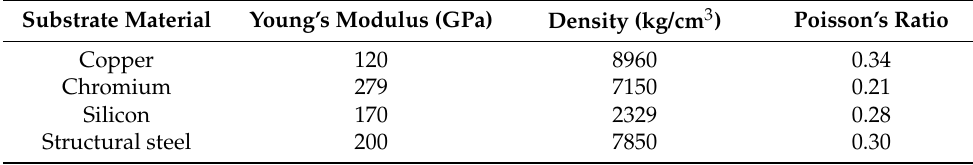
Table 3. Physical parameters of copper, chromium, silicon and structural